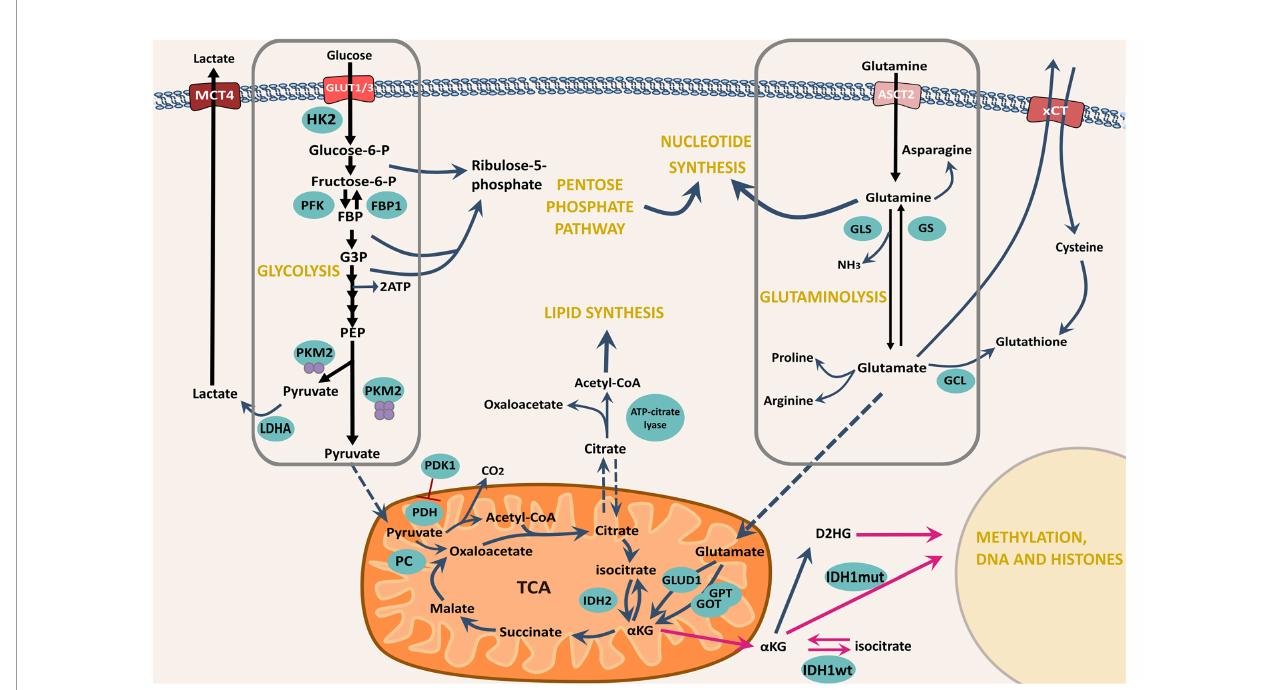
FIGURE 3 | Schematic showing some of the major metabolic pathways for GSC bioenergetic function and potential adaptability. The import of both glucose and glutamine are emphasised as the major nutrients available for cellular uptake though their respective transporters. Glucose is imported through the cellularly expressed glucose transporter, in this case either GLUT1 or GLUT3 and is enzymatically processed in the cytoplasm to pyruvate. Glycolytic processing can yield intermediate precursors largely subject to processing via the PPP – a major nucleotide synthesis pathway. Complete glycolytic processing to pyruvate is determined by the fi nal enzymatic step - conversion of PEP by PKM2, yielding either lactate for export through MCT4 or pyruvate for mitochondrial entrance and processing via TCA and OXPHOS. In addition, Glutamine is imported via the ASCT2 transporter and enzymatically converted to glutamate via GLS. The reverse reaction is catalysed by GS. Direct conversion of Glutamate to cytoplasmic glutathione can take place via GCL, however, indirect conversion can also take place via xCT export, coupled to cystine import. Glutamate can be processed further to synthesise amino acids and lipids but can similarly be used for TCA anaplerosis via mitochondrial import and conversion to a KG by the transaminases GPT and GOT or GLUD. Black arrows represent glycolysis and glutaminolysis. Blue curly arrows represent the shuttling of intermediates from glycolysis and glutaminolysis and their processing by subsequent enzyme-catalysed reactions. Blue dashed arrows represent mitochondrial import/export. Magenta arrows represent the reactions that take place as a result of IDH1/2 mutations. a KG, a -ketoglutarate; ECT, Electron transport chain; FBP1, Fructose-1,6 bisphosphatase 1; G3P, Glyceraldehyde-3-phosphate; GCL, Glutamate-cysteine ligase; GLS, Glutaminase; GLUD1, Glutamate dehydrogenase; GLUT1/3, Glucose transporters 1/3; GOT, Glutamic oxaloacetic transaminase; GPT, Glutamate pyruvic transaminase; GS, Glutamine synthetase; HK2, hexokinase 2; IDH, Isocitrate dehydrogenase; LDHA, lactate dehydrogenase A; MCT4, Monocarboxylate transporter 2; OXPHOS, Oxidative phosphorylation; P, Phosphate; PC, Pyruvate carboxylase; PDH, Pyruvate dehydrogenase; PDK1- Pyruvate dehydrogenase kinase 1 PEP- Phophoenolpyruvate; PFK, Phosphofructokinase; PKM2, Pyruvate kinase M2, TCA, The citric acid